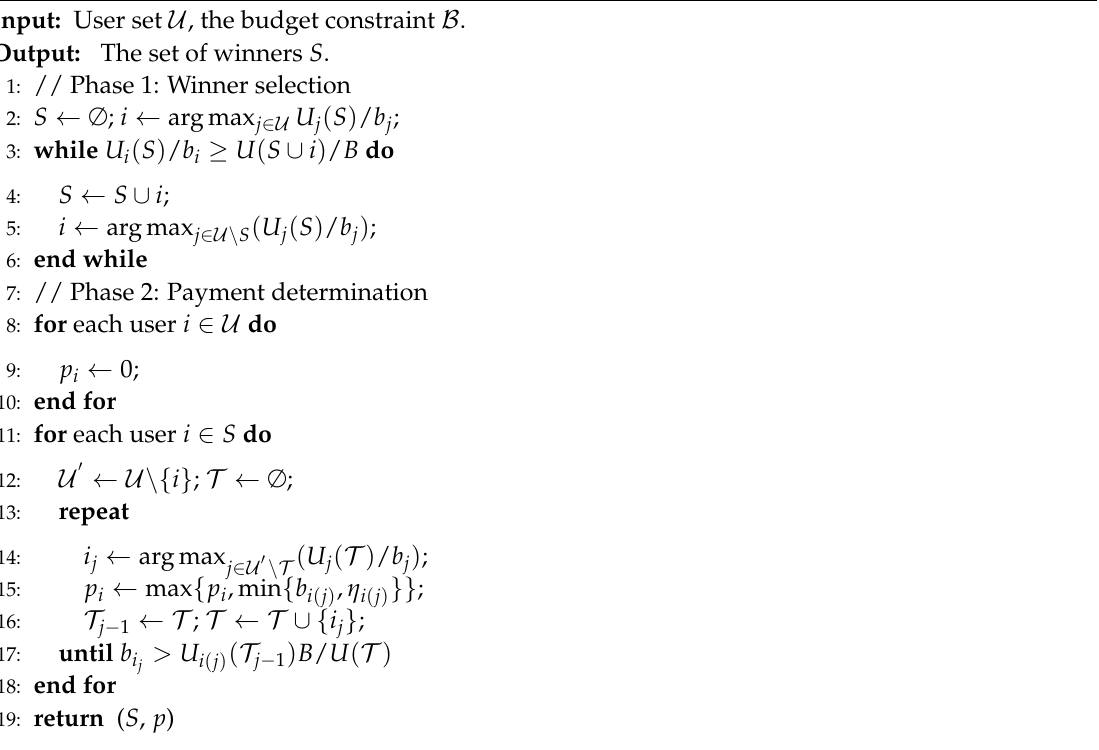
Algorithm 1 An Auction Mechanism for Submodular Sensing Jobs Under the Budget